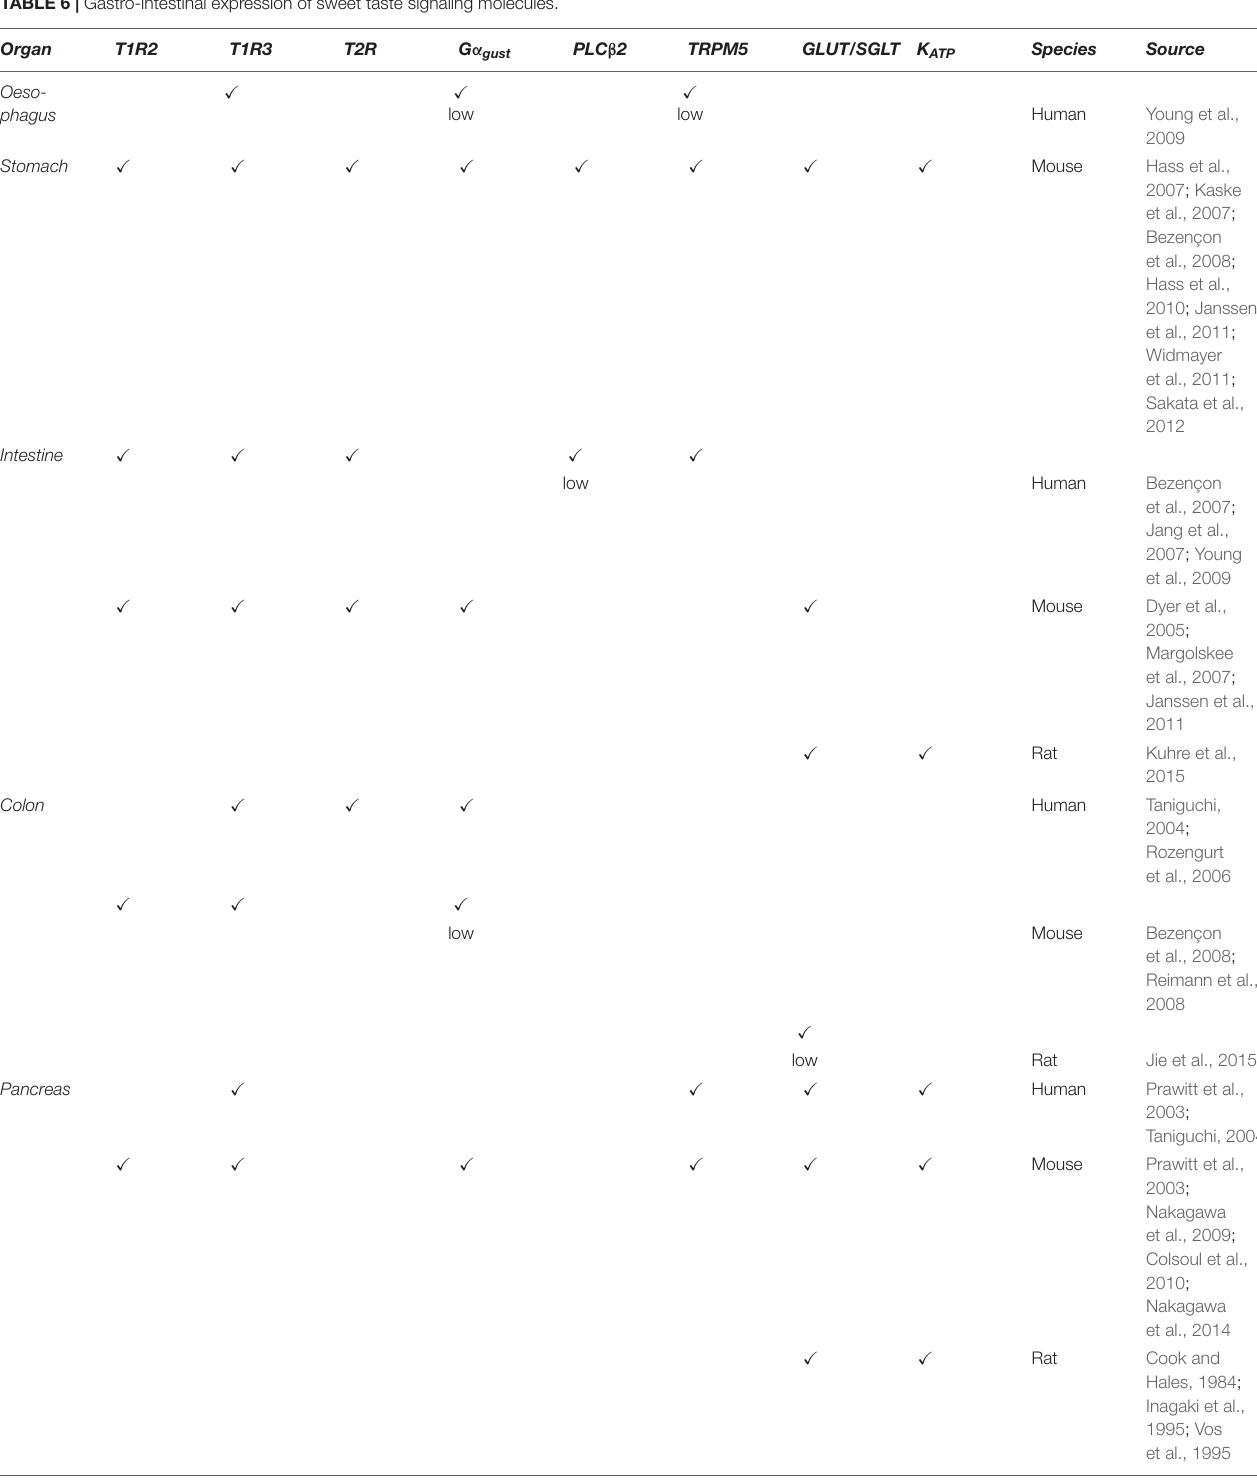
TABLE 6 | Gastro-intestinal expression of sweet taste signaling molecules. Organ T1R2 T1R3 T2R G α gust PLC β 2 TRPM5 GLUT/SGLT K ATP Species Source Oeso- phagus low low Human Young et al.,